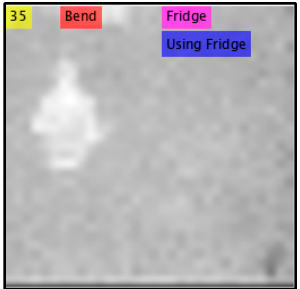
Figure 5. Annotated frame showing the person bending at the fridge .